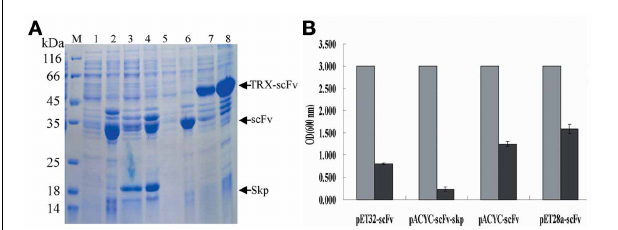
FIGURE 3 | Analysis of solubility of expressed products. (A) Analysis of solubility of the expressed protein by SDS-PAGE. Lane 1, 3, 5, and 7: the soluble cell lysates for pACYC-Duet- scFv , pACYC-Duet- scFv-skp , pET28a- scFv , and pET32a- scFv , respectively; Lane 2, 4, 6, and 8: the insoluble cell lysates for pACYC-Duet- scFv , pACYC-Duet- scFv-skp , pET28a- scFv , and pET32a-scFv, respectively. (B) Cell lysates analysis by OD 600 assay (gray bar indicates the concentration of cells after protein expression; black bar indicates the concentration of cell lysates after ultrasonication).